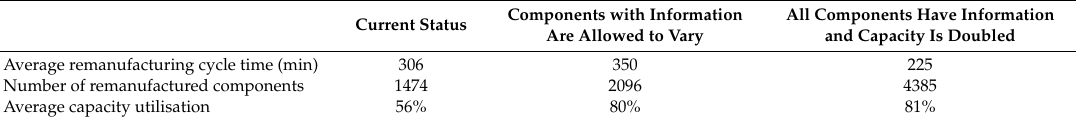
Table 4. Comparison of simulation results with current remanufacturing capacity status. Components with Information All Components Have Information Current Status Are Allowed to Vary and Capacity Is Doubled Average remanufacturing cycle time